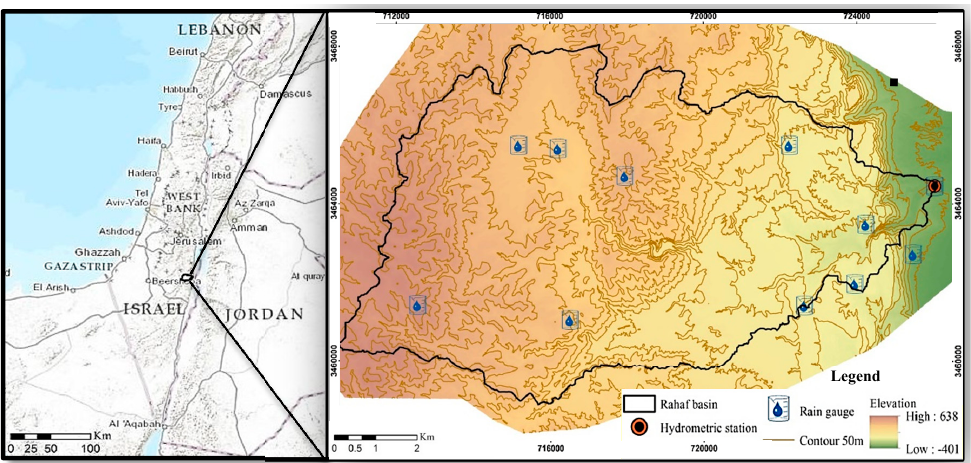
Figure 1. Map of the Rahaf watershed outline by the black line in the enlarged right figure, the rain gauges, and the location of the hydrometric station.